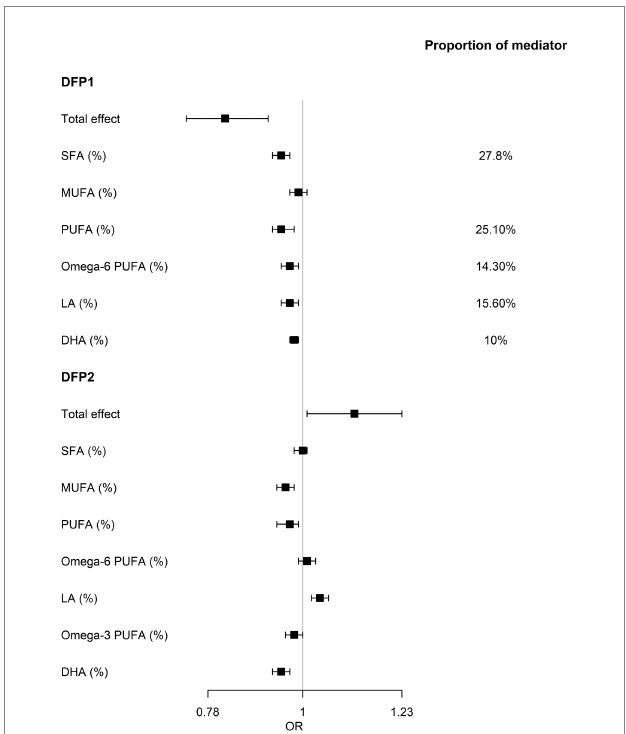
FIGURE 4 Results of the mediation analysis. Serum fatty acids mediates the relationship between DFPs and NAFLD. OR, odds ratio of mediation effect. Proportion of mediator, proportion of the effect of DFP on NAFLD that goes through fatty